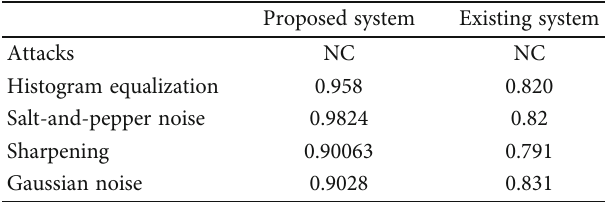
Table 6: Comparison results of the proposed system against an existing study